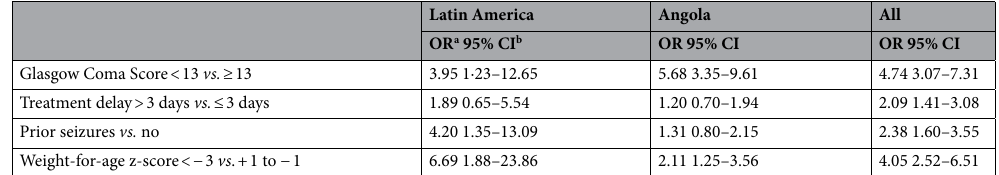
Table 4. Multivariate analysis of variables associated with death from childhood bacterial meningitis in Latin America and Angola. A comparison of the influence of severity on admission (Glasgow Coma Score ˂ 13), treatment delay > 3 days, seizures before or during admission, and severe underweight (= weight-for- age z-score < − 3) vs . normal weight (weight-for-age z-score + 1 to − 1). In Finland, too few deaths impeded multivariate analysis. a Odds ratio. b Confidence